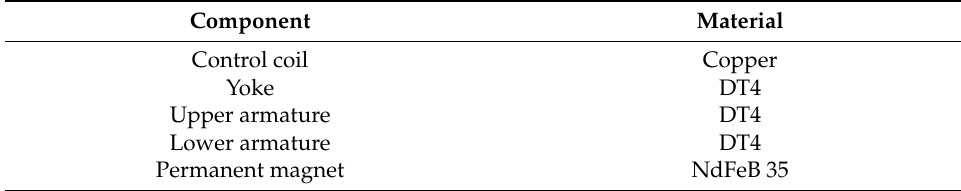
Table 5. Magnetic properties of DT4 [29].